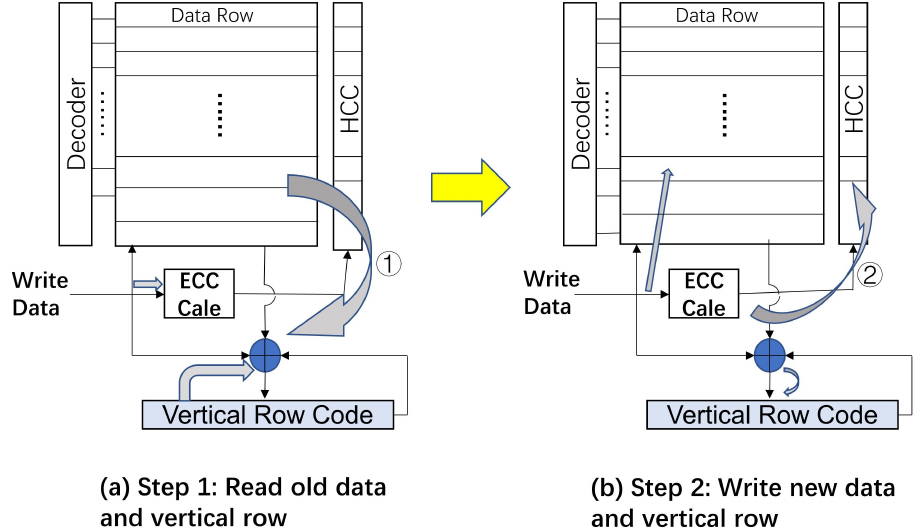
Figure 3. Architecture of 2D Error correction Code Protection SRAM. The diagram shows the vertical update process in two